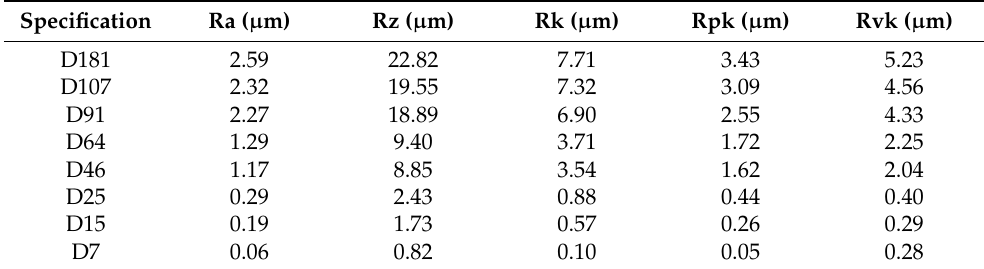
Table 3. Results of the surface roughness for the used honing